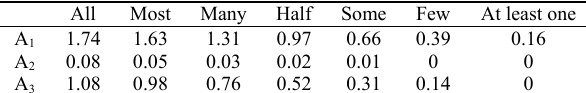
Table 11. The overall separation measures of alternatives from the positive ideal